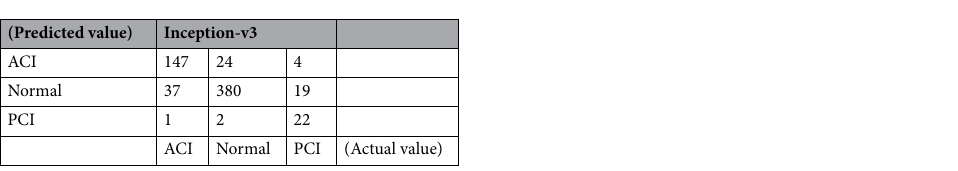
Table 3. Confusion matrix of Inception-v3 model in classifying stroke vascular territory.